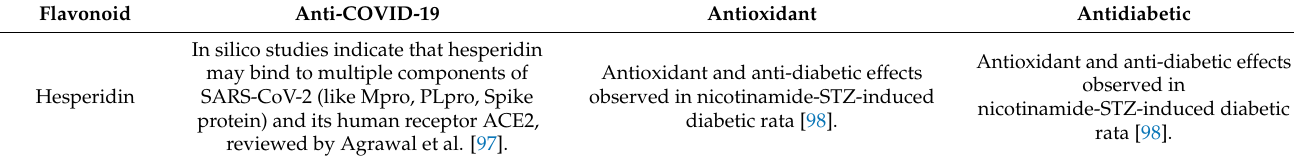
Table 1. Cont. Flavonoid Anti-COVID-19 Antioxidant Antidiabetic In silico studies indicate that hesperidin may bind to multiple components of Hesperidin